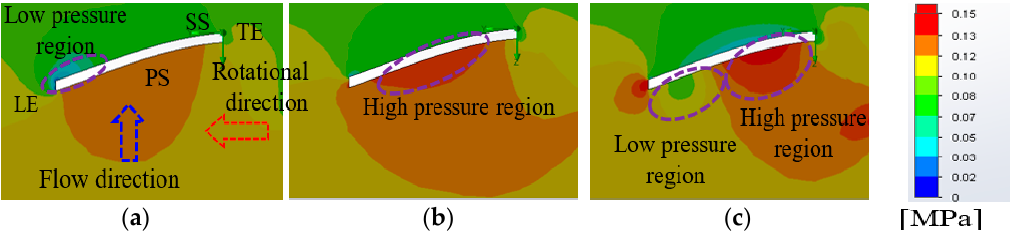
Figure 12. Contour of pressure on the blade suction side for different TSR : ( a ) TSR = 1.0; ( b ) TSR = 2.5; ( c ) TSR = 4.0.